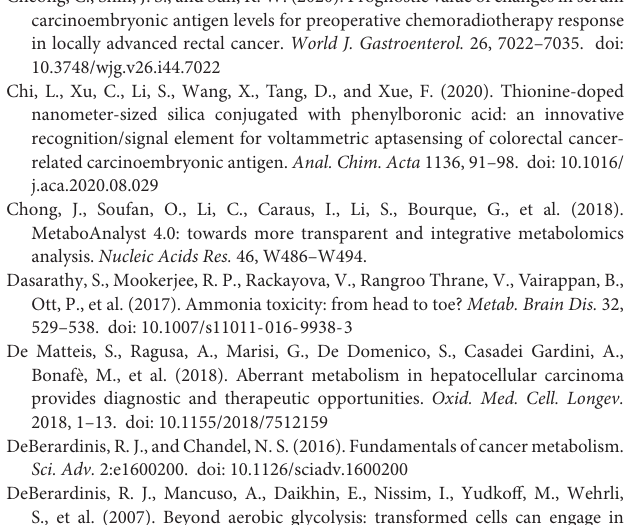
blot to detect the expression of GDH1, GS, and a-tubulin from 14 pairs of cancer and adjacent tissues of HCC. (C) Schematic diagram of cell model. 200, 000 HL7702 or 100, 000 HL-7702 and 100, 000 MHCC97H were cultured separately. (D) Relative urea excretion of the cell lines as indicated. (E) Relative ammonia abundance in the upper medium of the cell lines as indicated. (F) Relative ammonia abundance in the lower medium of the cell lines as indicated. (G) Relative urea abundance in 10 pairs of fresh HCC and adjacent tissues. (H) Relative ammonia abundance in 10 pairs of fresh HCC and adjacent tissues. Supplementary Figure 5 | The relationship of urea cycle with ammonia metabolism in cancer cells. (A) Western blot confirmed the knockdown of CPS1 in HepG2 cells. (B) Relative ammonia excretion in HepG2/Scramble, HepG2/shCPS1 for 8 h. (C) Relative urea excretion in HepG2/Scramble, HepG2/shCPS1 for 48 h. (D) Western blot confirmed the over-expression of CPS1 in HCT116 cells. (E) Relative ammonia excretion in HCT116/Vector, HCT116/CPS1 for 8 h. (F) Relative urea excretion in HCT116/Vector, HCT116/CPS1 for 48 h. Values are the means ± SD of three independent